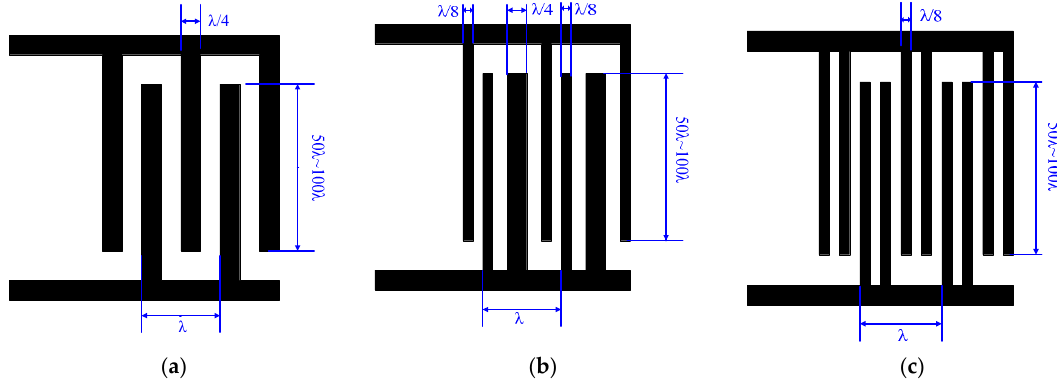
Figure 5. Three different interdigital transducer (IDT) structures: ( a ) bidirectional IDT, ( b ) electrode width controlled single-phase unidirectional transducer (EWC/SPUDT) IDT, and ( c ) split IDT.